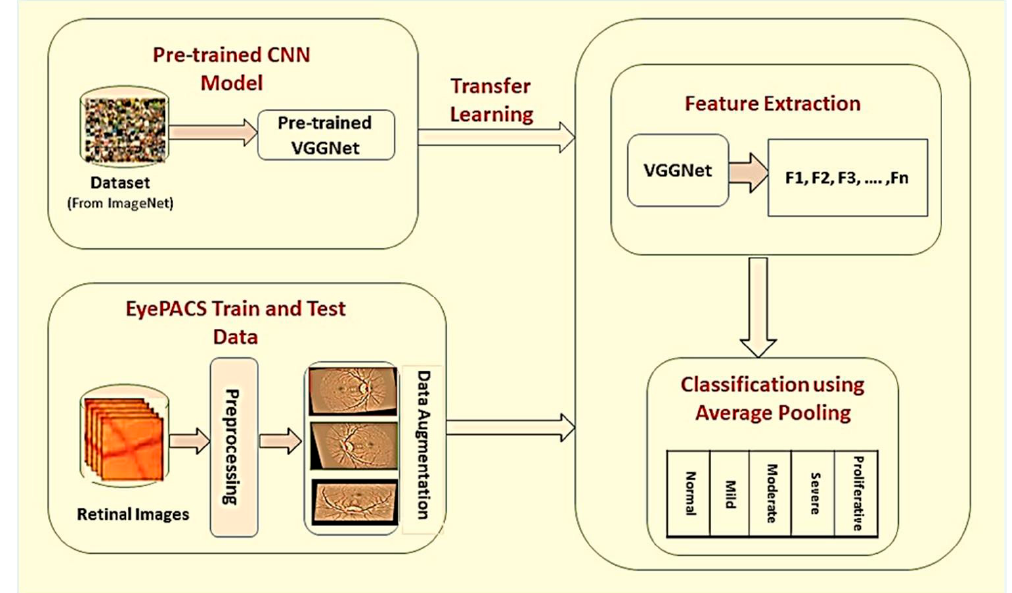
Figure 2. Proposed framework for detection and classification of diabetic retinopathy. In the first phase, retinal images are preprocessed, and data augmentation operations are performed individually on each grade of DR to improve classification accuracy. In the last, model-based on transfer learning is used for automatic features extraction and classification of DR into different stages.